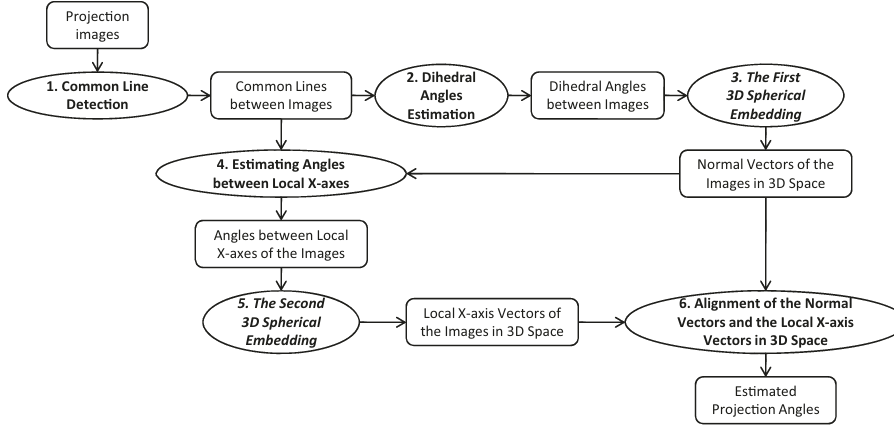
Fig. 7 The fl owchart of the proposed method. The ovals represent processing methods, and the rounded rectangles represent data.